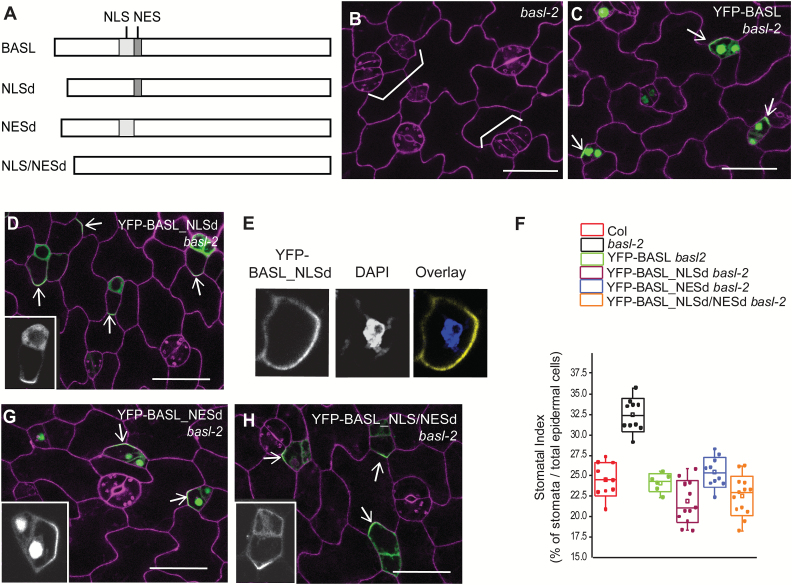
BASL requires the NLS for its nuclear import.(A) Diagram representing the 262 amino-acid WT BASL protein and sites of modifications. Light grey box indicates the putative NLS and the dark grey box marks the putative NES. NLSd, the NLS deleted in BASL; NESd, the NES deleted; NLS/NESd, the NLS and NES both deleted. (B–D) Confocal images of 2-dpg adaxial cotyledon to show that without the NLS, BASL is no longer restricted to the nucleus. Protein localization is shown in green and cells were outlined with PI staining (magenta). White brackets label clustered stomata or lineage cells. The clustered stomata in the loss-of-function mutant basl-2 (B) were complemented by expressing both YFP-BASL (C) and YFP-BASL_NLSd (D). White arrows point to protein polar accumulation. The inset in D shows the YFP channel only for a closer view of BASL_NLSd localization. Scale bars = 25 µm. (E) Confocal images of YFP-BASL_NLSd (yellow) in the cell counterstained with DAPI (blue), a fluorescent dye that binds to nucleic acids to show the nucleus, suggesting that BASL_NLSd is not expressed in the nucleus. (F) Phenotypic quantification of transgenic plants expressing YFP-tagged proteins. Stomatal index was calculated as the total number of stomata over the total number of epidermal cells and expressed as a percentage. The box plots were created by OriginLab. Each dot represents the stomatal index of an individual seedling (n = 10–12 seedlings, 5 dpg); for each seedling, about 150–200 cells (1500–2000 in total) were scored. This applies to other figures in which this format is used. Note the similar rescue effect of YFP-BASL_NLSd, _NESd, and _NLS/NESd in basl-2 compared to that of YFP-BASL. All BASL-related constructs were driven by the BASL promoter. (G–H) Confocal images of YFP-BASL_NESd (G) and YFP-BASL_NLS/NESd (H) (green) in basl-2 to show protein localization (green) and complementation (cells outlined with PI staining, magenta). BASL does not rely on the NES for nuclear export, but requires the NLS for nuclear import. Arrows indicate proteins polarized to cortical crescents. The insets show the YFP channel only. Scale bars = 25 µm.